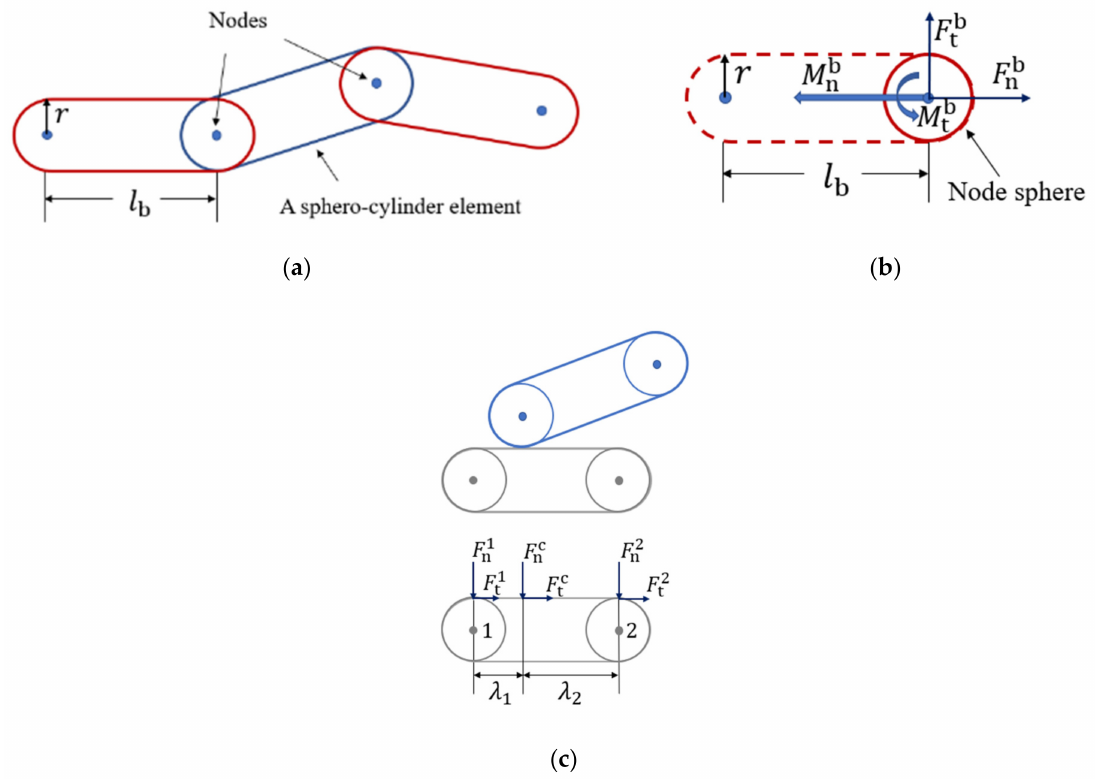
Figure 1. ( a ) A sketch of the flexible fiber model, ( b ) bond forces, and moments exerted on a node sphere, as well as ( c ) contact forces distributed to the two node